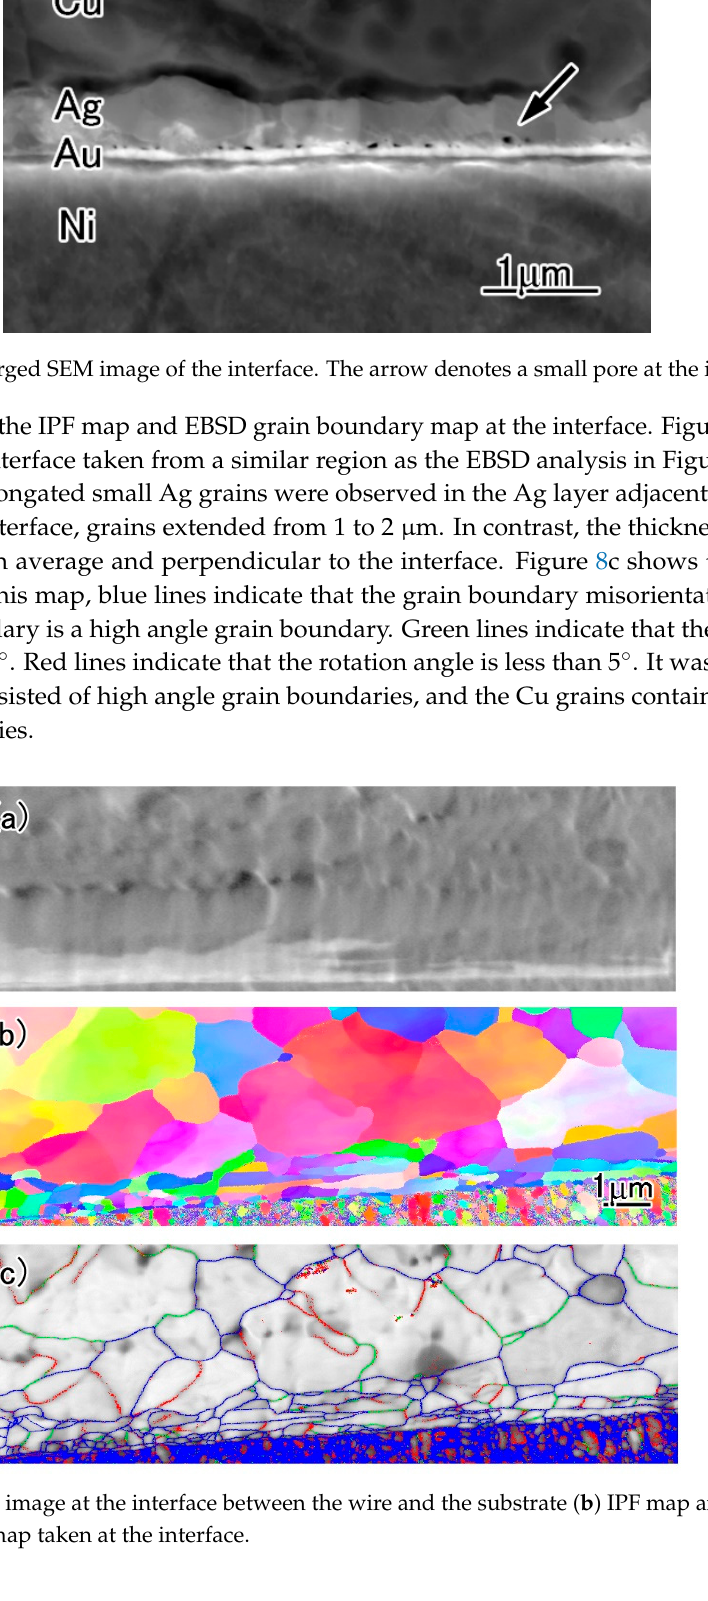
Figure 8. ( a ) SEM image at the interface between the wire and the substrate ( b ) IPF map and ( c ) EBSD grain boundary map taken at the interface.